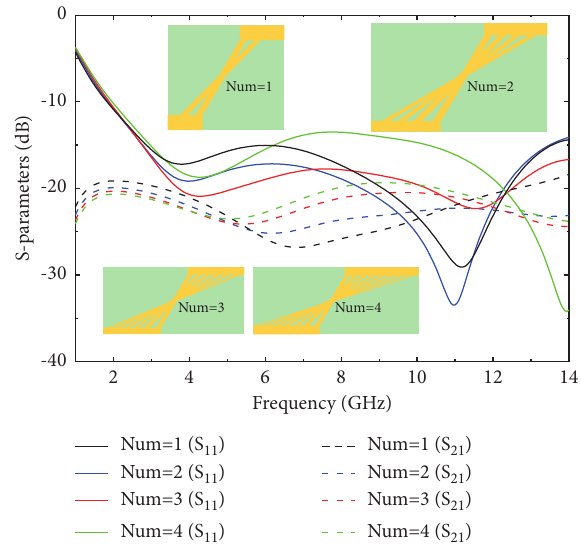
Figure 9: S -parameter simulation results of different numbers of X-shaped